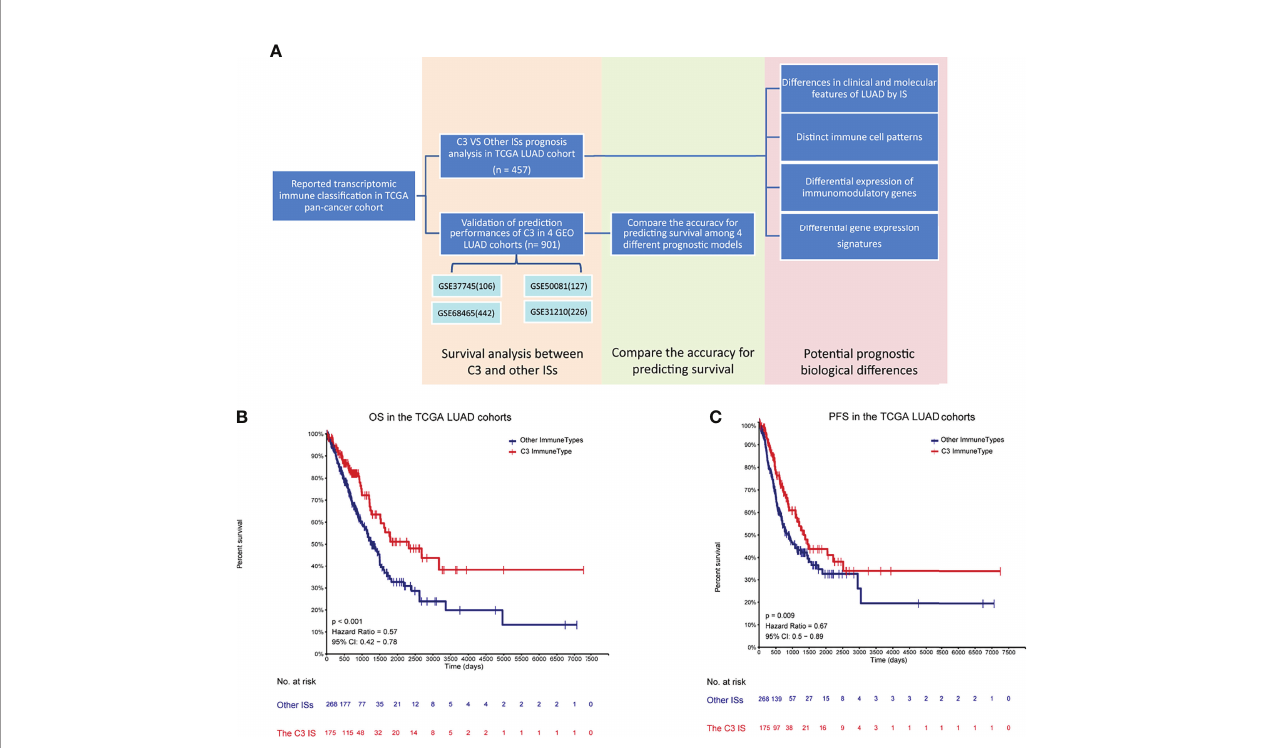
FIGURE 1 | Developments and validations of the C3 immune subtype (IS) (A) Flowchart of developments and validations of the C3 immune subtype (IS). Overall survival (OS) (B) and progression-free interval event (PFI) (C) by immune subtypes (C3 vs. Other ISs) in TCGA LUAD cohort (n = 457) to verify the relationship between the C3 IS and prognosis. P-value was calculated by log-rank